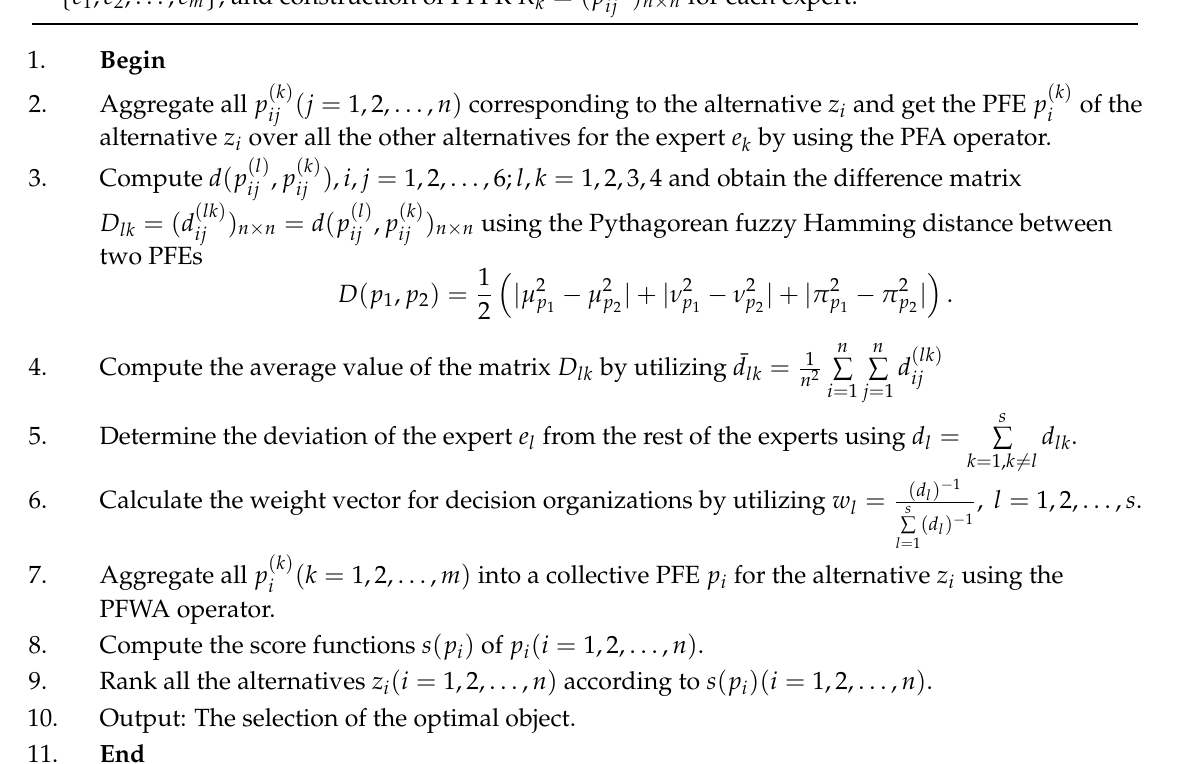
z 1 , z 2 , . . . , z n , a set of experts e { }